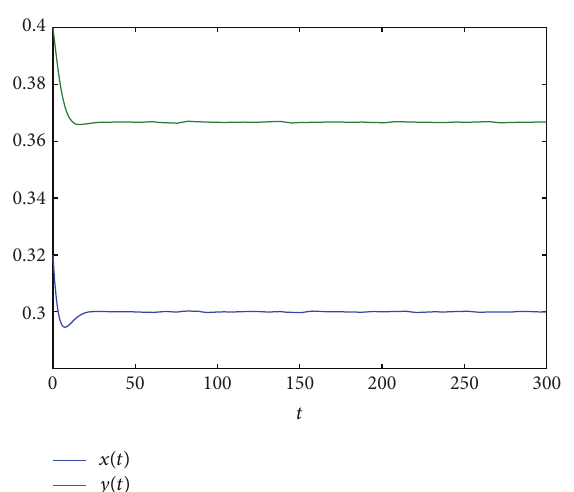
Figure 7: The time series chart for 𝑥 and 𝑦 without impulse.